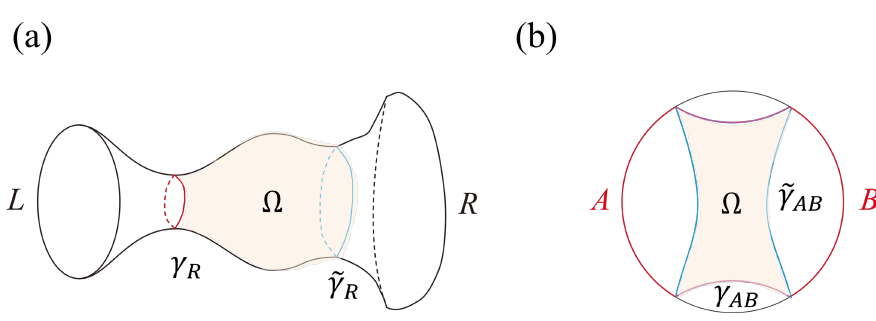
Figure 3 . Two example cases with a subleading quantum extremal surface corresponding to a smaller entanglement wedge. (a) A two-sided black hole where the right boundary R has an coarse- grained entropy that is larger than entanglement entropy. (b) Two regions AB for which the actual entanglement wedge is connected, and there is a subleading quantum extremal surface ˜ γ AB = γ A γ B which is the disjoint HRT surface of A and B